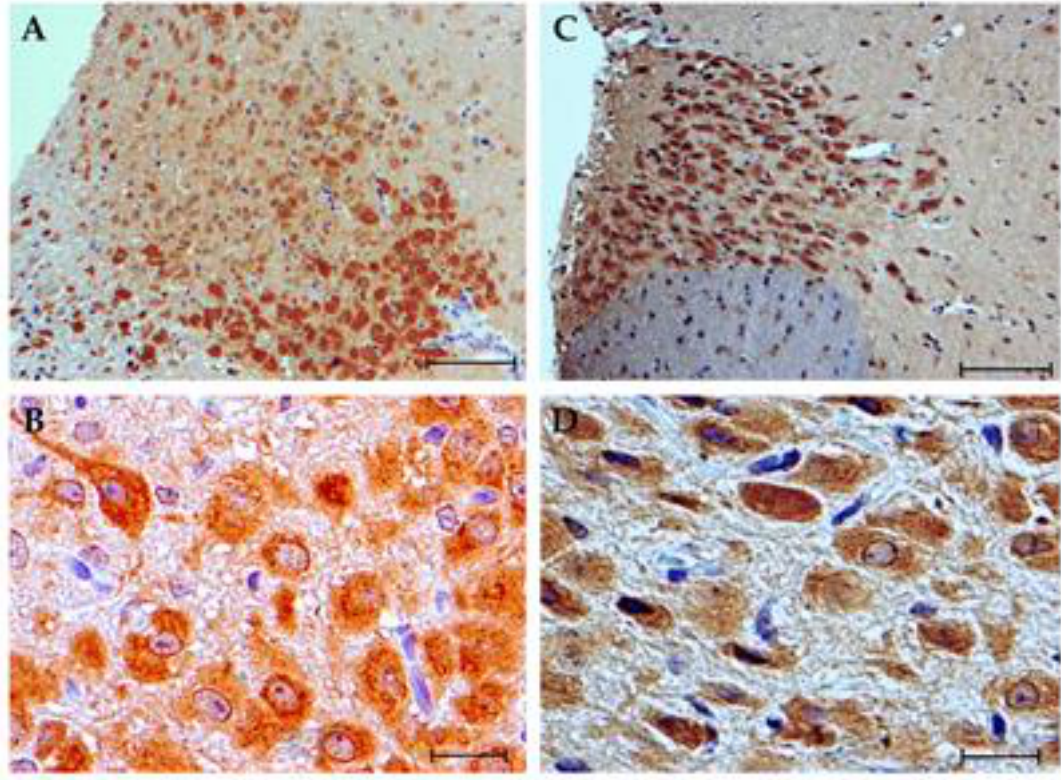
Figure 3. Cxcl16 expression in nucleus accumbens. ( A , B ), ISO group. An intense and diffuse expression is observed in the soma of numerous neurons in the shell zone of the nucleus accumbens which contrasts in this case with the negativity of the glial cells. ( C , D ), EtOH group. Cytoplasmic expression appreciated in abundant cells of slightly lower intensity vs. the ISO group. Scale bar in ( A ) and ( C ) = 100 μ m. Scale bar in ( B ) and ( D ) = 20 μm.